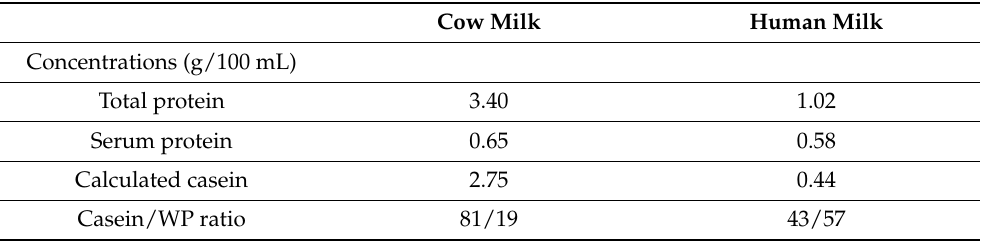
Table A1. Protein concentration of human and cow milk samples as determined in our